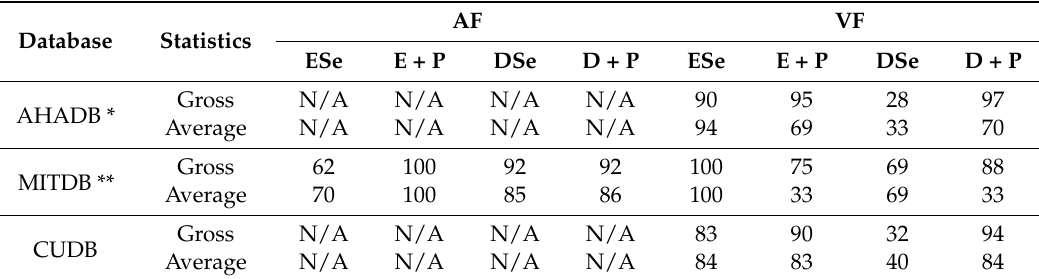
Table 3. The entire atrial fibrillation (AF) and VF evaluation result. (* = exclude records 2202, 8205; ** = exclude records 102, 104, 107, 217; N/A: not available. ESe = Episode sensitivity, E + P = Episode positive predictivity, DSe = Duration sensitivity, D + P = Duration positive